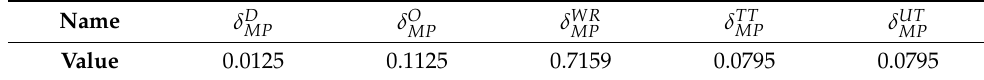
Table 13. Final estimated importance weights of AHP of mission point.